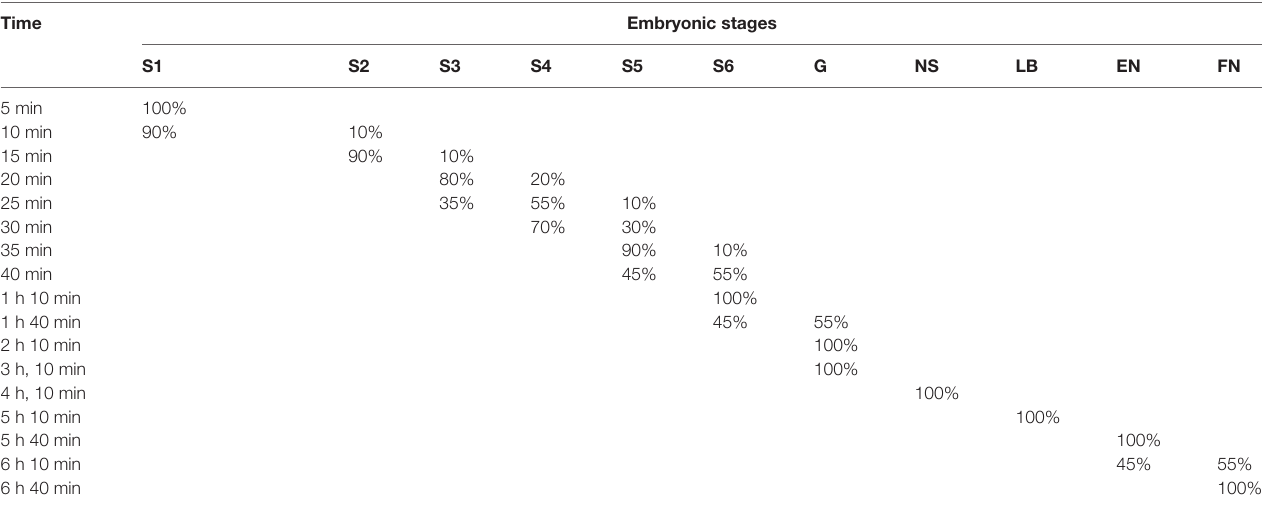
Embryogenesis was divided into following stages: fertilized egg (S1), 2-cell stage (S2), 4-cell stage (S3), 8-cell stage (S4), 16-cell stage (S5), multicellular stage (S6), grastrula stage (G), no structure visible (NS), limb bud stage (LB), early nauplii (EN), and final nauplii just before hatching